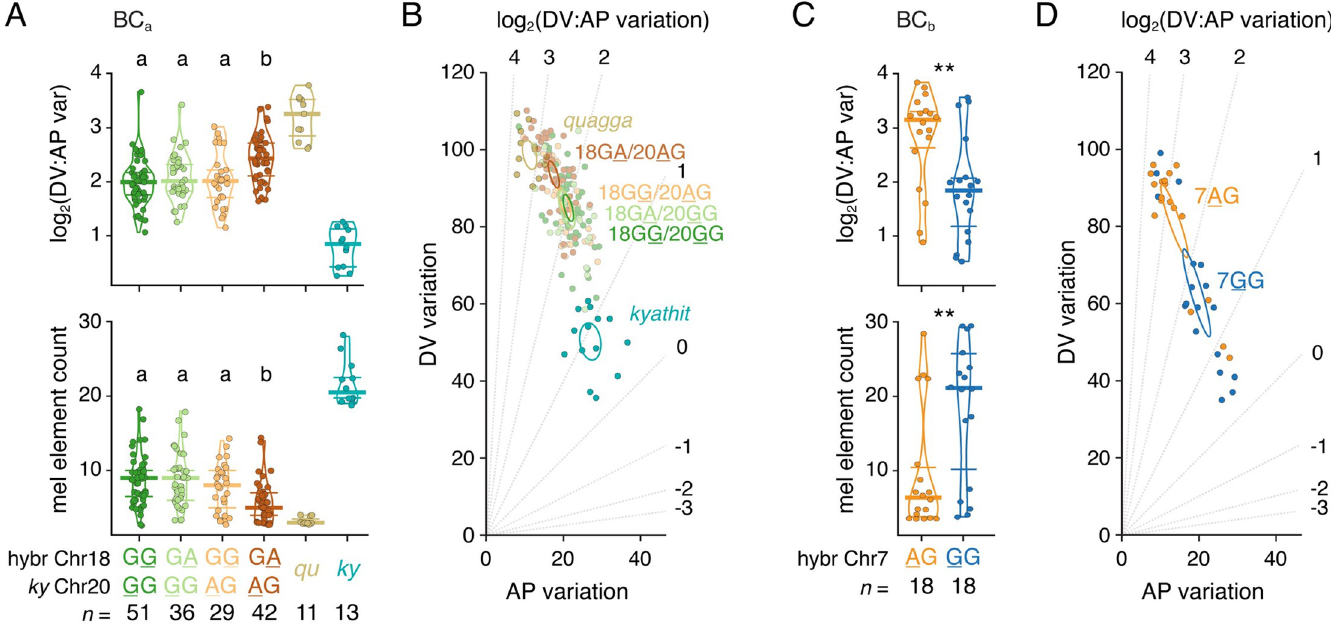
Fig 7. Epistatic relationships between QTL influence pattern phenotype. (A) Genotypes at Chr18:5246981 and Chr20:23025453 linked to variants affecting log 2 (DV: AP variation) and melanophore element count in BC a progeny. Genotypes are listed as maternally-inherited D . kyathit allele followed by paternally inherited allele with phenotype-associated alleles underlined. Bars indicate medians ± interquartile range. Overall analyses of variance for allelic combinations in BC a progeny: upper , F 3,154 = 7.26, P < 0.0001; lower , F 3,154 = 10.07, P < 0.0001). Means not significantly different from one another ( P > 0.05) in post hoc Tukey-Kramer comparisons are indicated by shared letters above data points. (B) Three combinations of Chr18 and Chr20 alleles overlapped in morphospace. When striped alleles on Chr18 and Chr20 were together, a phenotype significantly more similar to that of D . quagga developed. Ellipses indicate 95% confidence intervals of means. (C) Genotype at Chr7:27412951 impacts log 2 (DV:AP variation) and melanophore element count in BC b progeny selected for striped and spotted phenotypes. Analyses of variance: left , F 1,34 = 9.30, P = 0.0044; lower , F 1,34 = 8.91, P = 0.0052. (D) Morphospace position was impacted by variants linked to maternally inherited D . kyathit alleles at Chr7:27412951. Most siblings with the A allele had patterns similar to D . quagga whereas progeny with the G allele were more similar to D . kyathit . (compare with representative parental species values in A). Statistical analyses in A and C used DV:AP variation and ln (melanophore elements), which stabilized among-group differences in residual variance evident in original